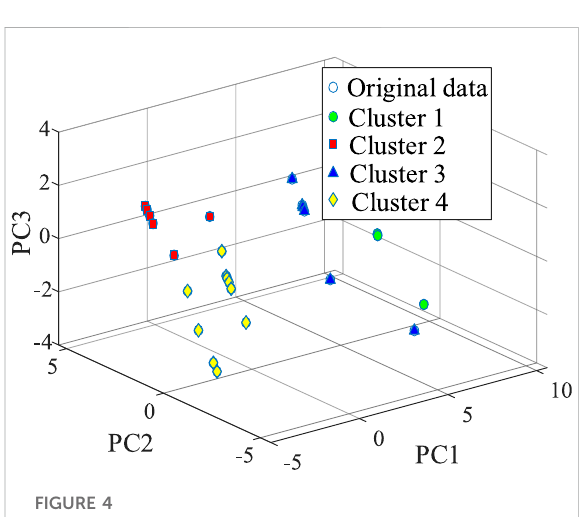
FIGURE 4 The clustering results for DFIG-based wind farm by WFCM.